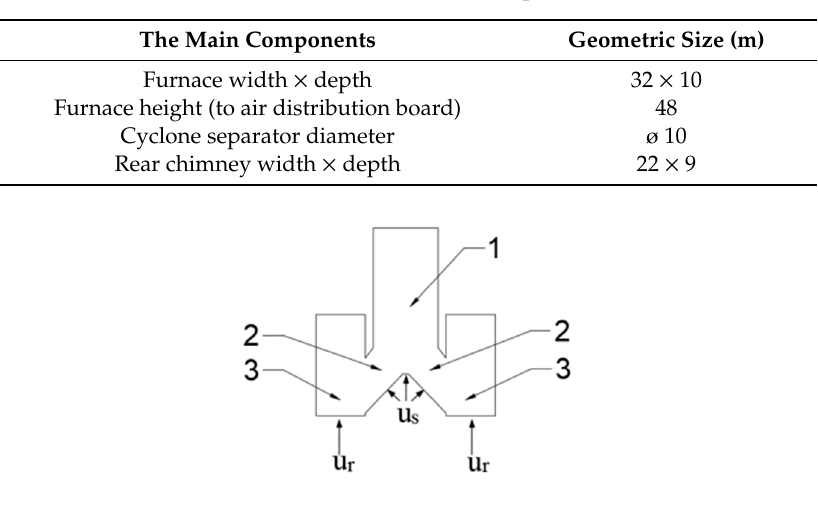
Table 1. Geometric dimensions of main components of the boiler.